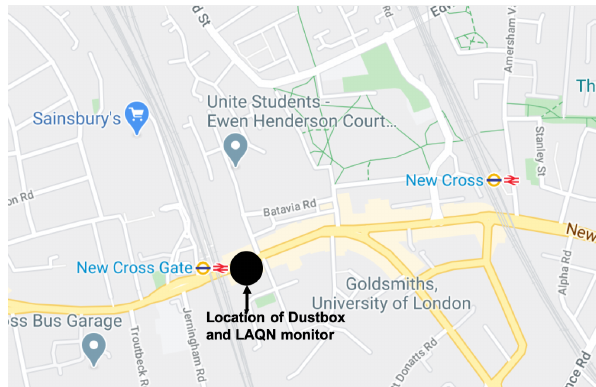
Figure 13. Location of Dustbox 2054 and LAQN monitor.